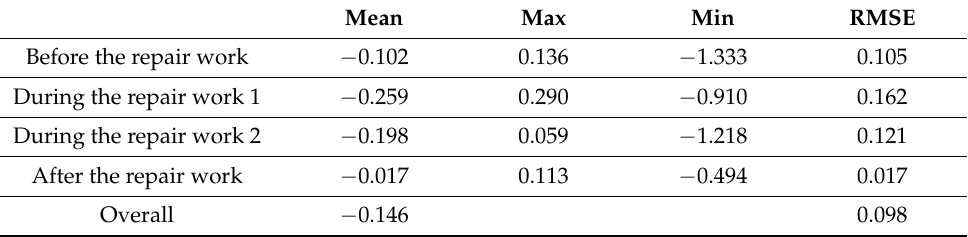
Table 1. Height measurement error (m) in SfM analysis compared with the total station